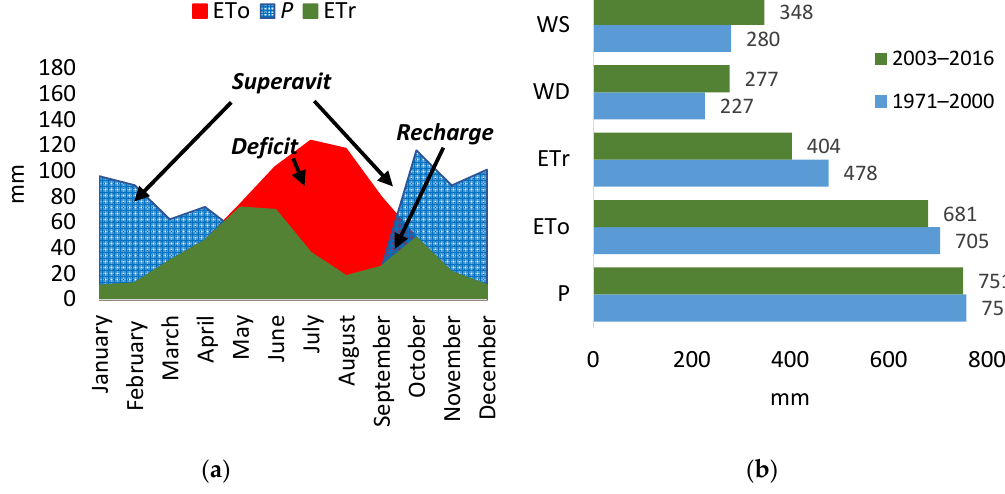
Figure 3. Soil water balance components in Bragança: ( a ) monthly distribution in the average year of the study period (2003–2016) and ( b ) annual totals average in the study period compared to the long-term (1971–2000) (maximum soil water storage, Smax = 100 mm).